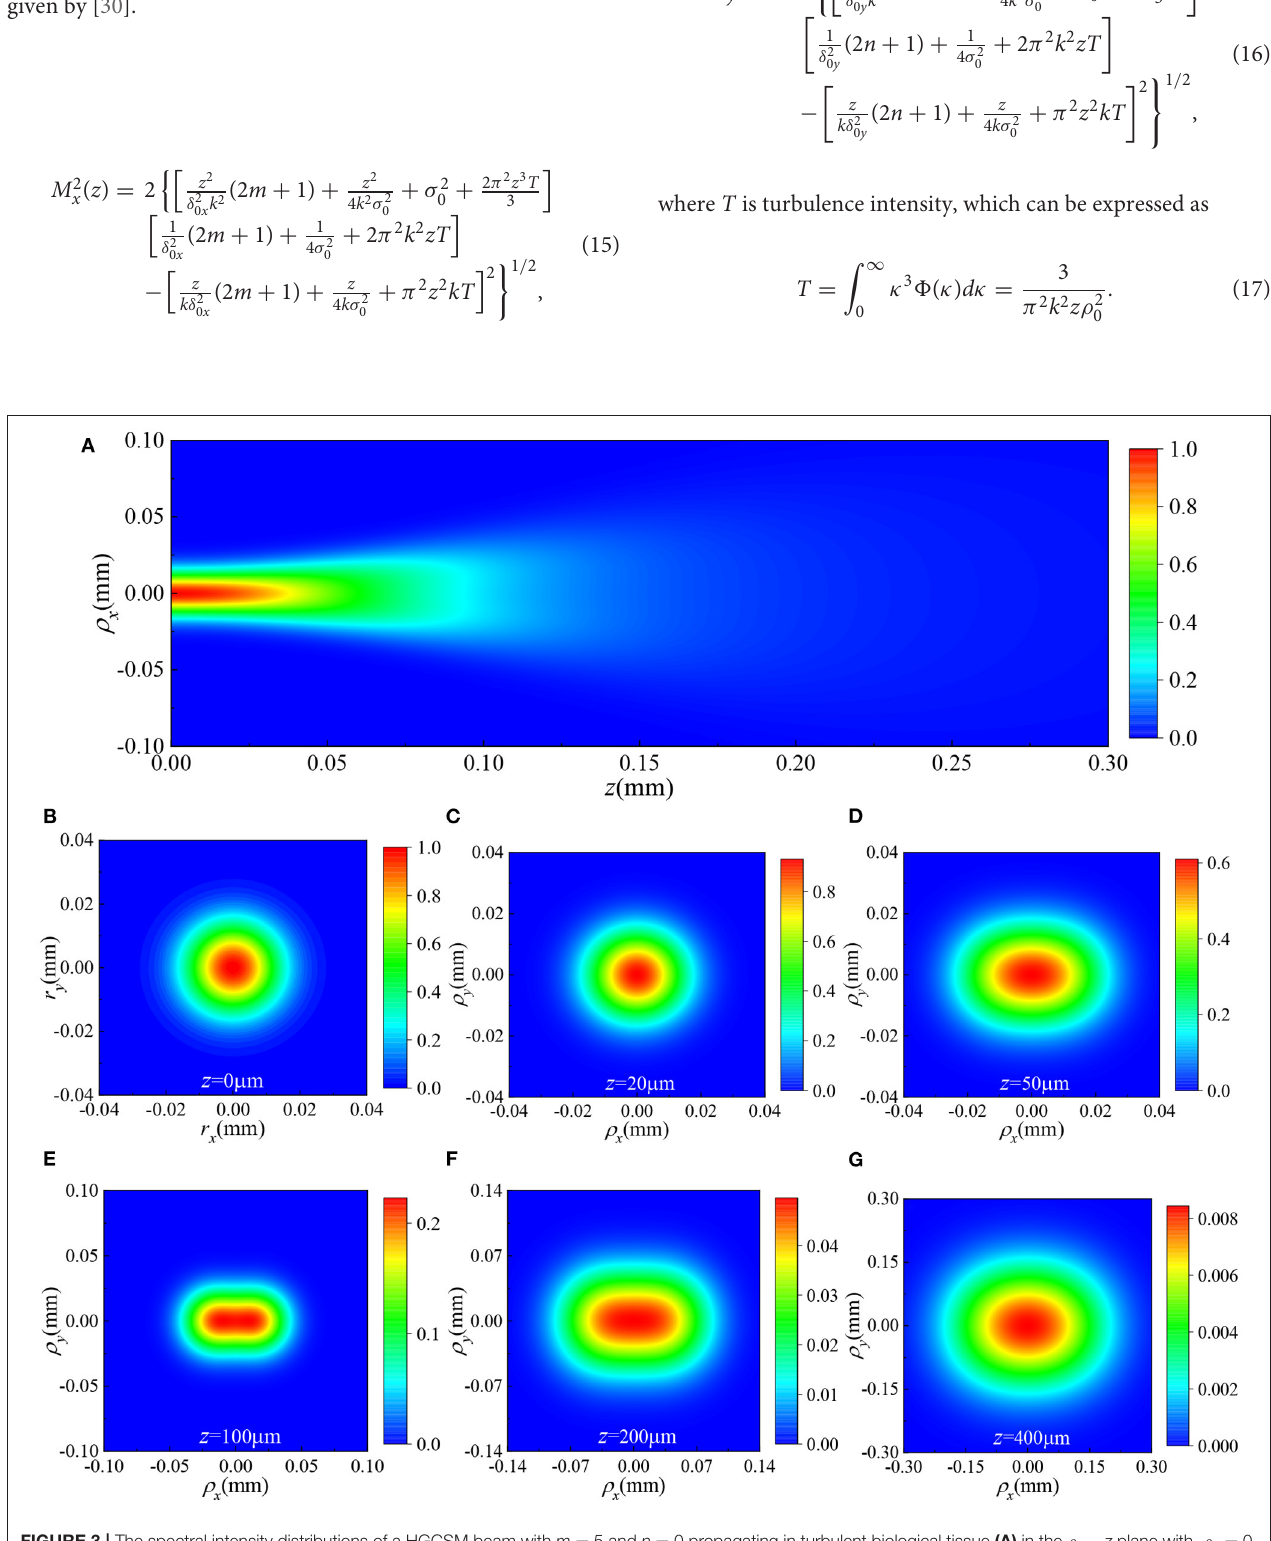
FIGURE 3 | The spectral intensity distributions of a HGCSM beam with m and (B–G) in the ρ x